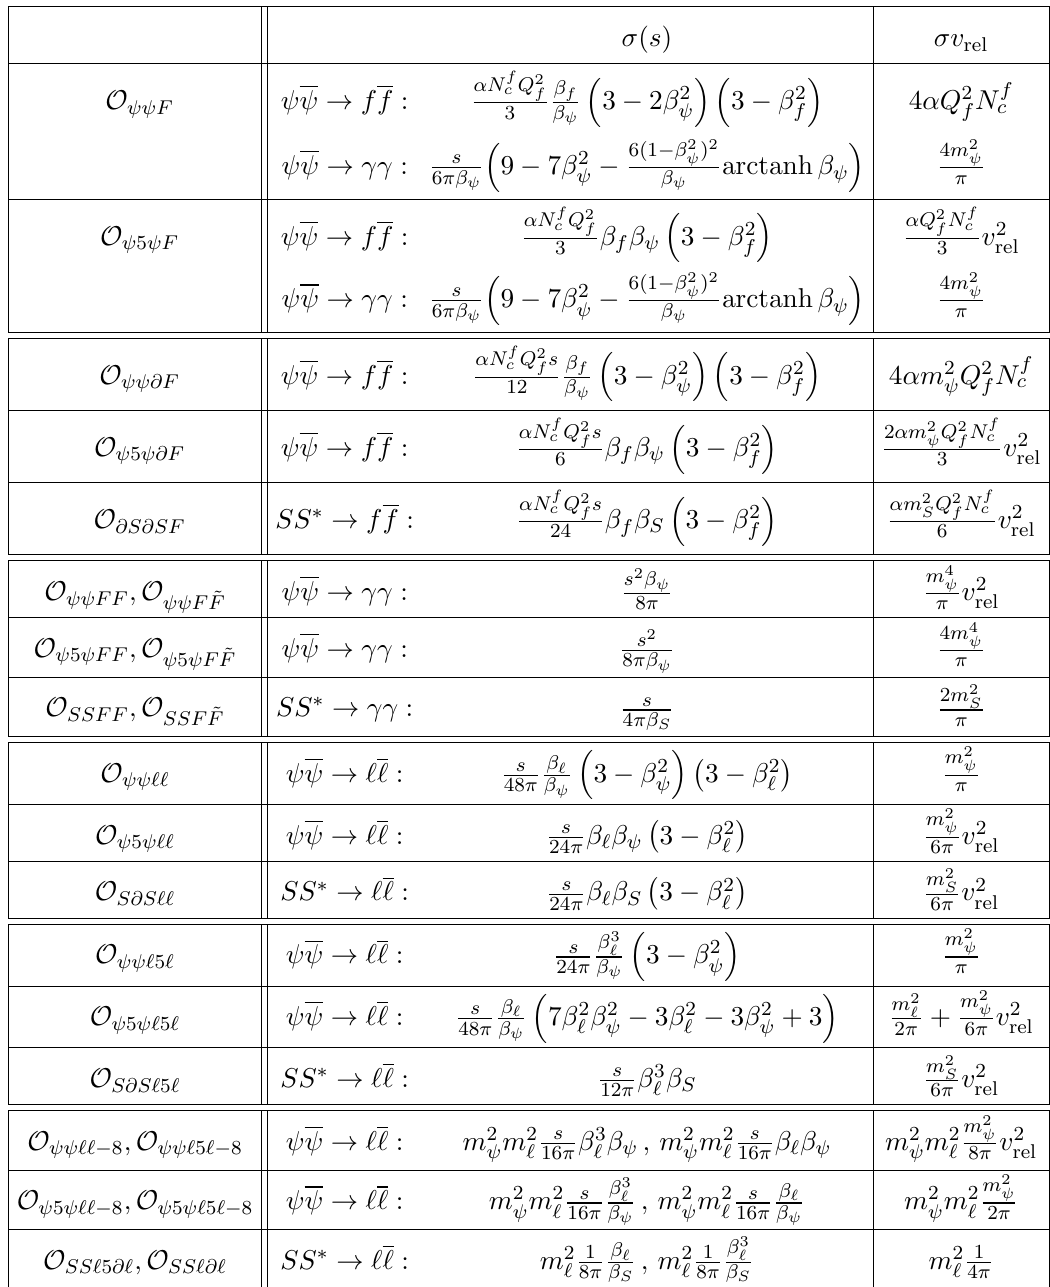
Table 3 . Annihilation cross sections for operators de(cid:12)ned in section 2 (with no numerical pref- actors except 1/2 for operators with Majorana fermions and real scalars). The scaling due to an 2 in each cross section, except for the annihilation into photons due operator coe(cid:14)cient is C / C 4 . Here (cid:12) 2 to and , which scale as =s ) 1 = 2 , Q f is the fermion charge i (cid:17) (1 (cid:0) 4 m i O F O 5 F / C and N f the fermion color factor. For the non-relativistic annihilation cross-sections to fermions we c only keep the leading terms in m 2 =m 2 . Note that operators involving @F do not contribute to DM f annihilation into photons at